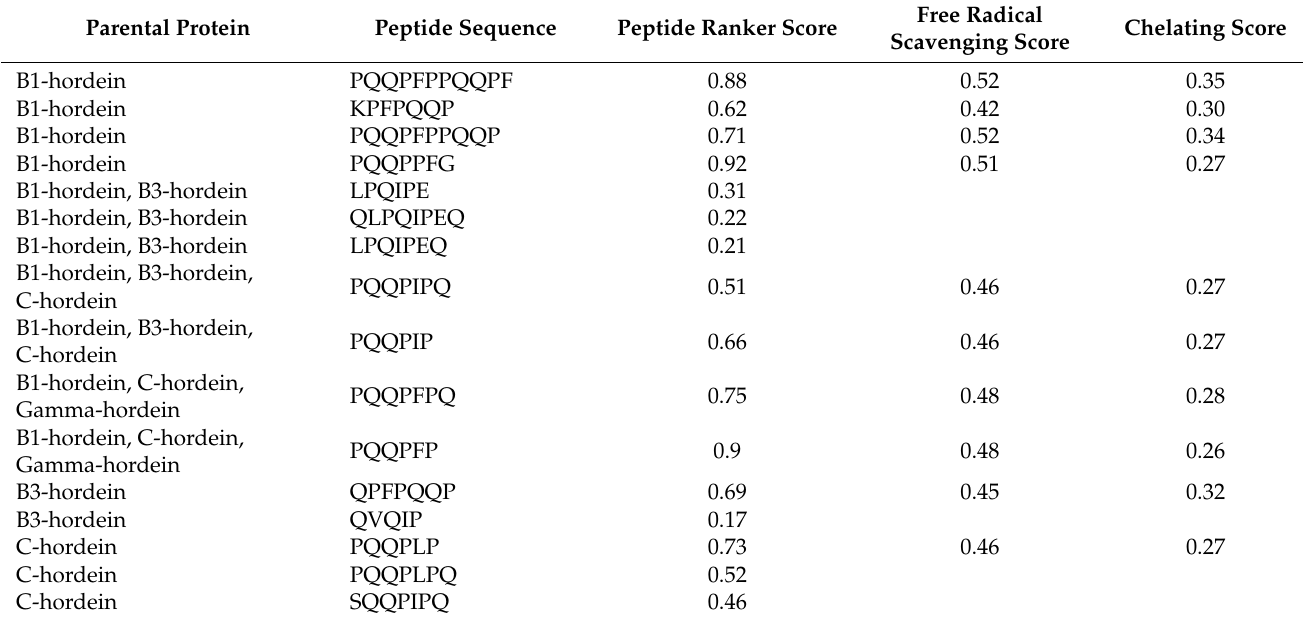
Table 7. In silico characterization of peptides from barley identified in the bioaccessible fraction of digested whey beverage ( Colada ). Antioxidant activity prediction by